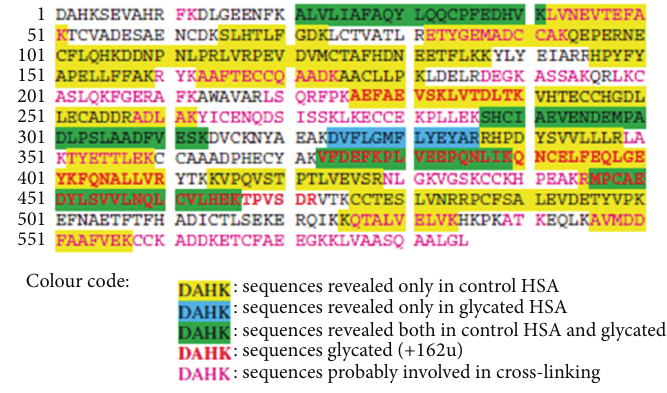
Figure 5: Peptides identified by accurate mass measurements based on HSA sequence. From [23], by kind permission of John Wiley and Sons through RightsLink, License no. 3064270300383.